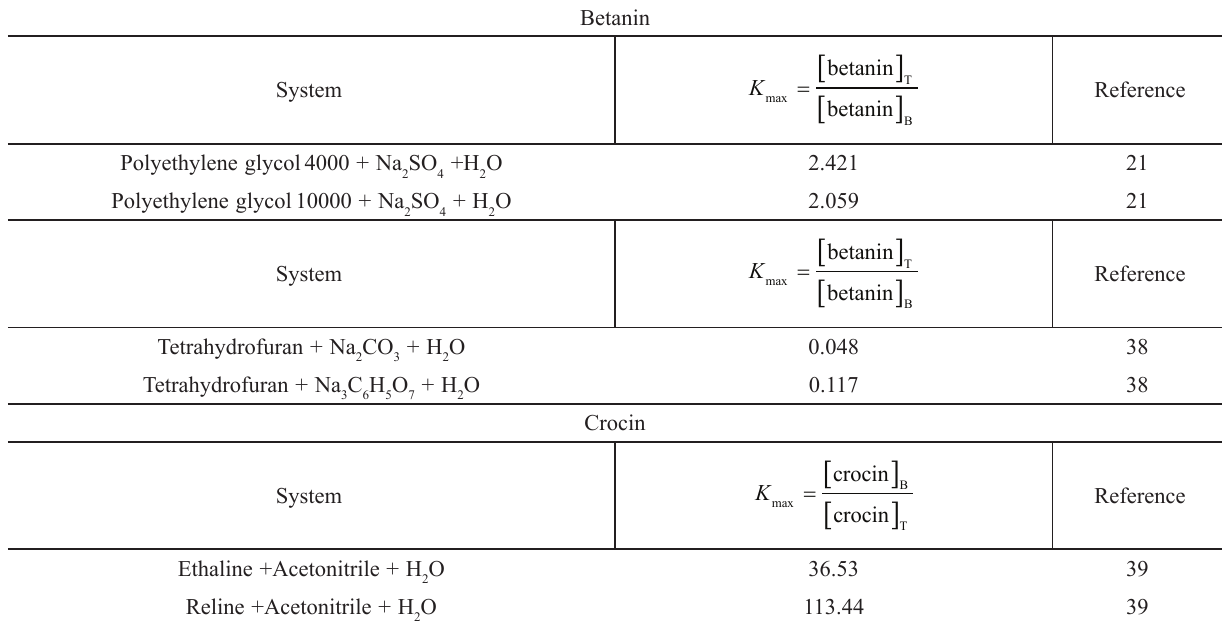
Table 5 – Comparison of the reported maximum partition coefficient (K 101 kPa in different